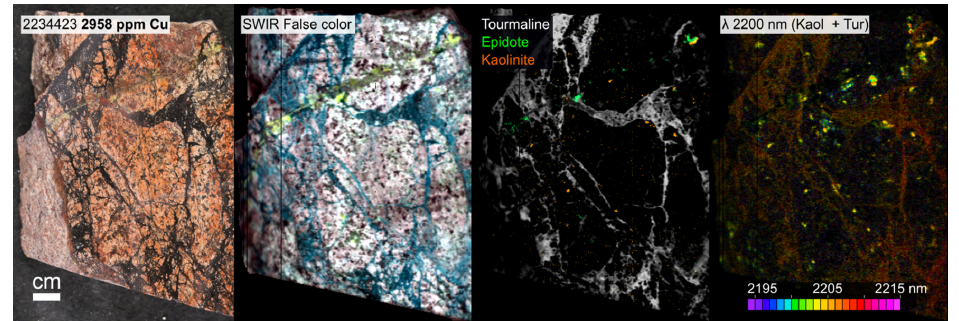
Figure A4. Sample 2015KB249, epidote vein with prehnite selvage.